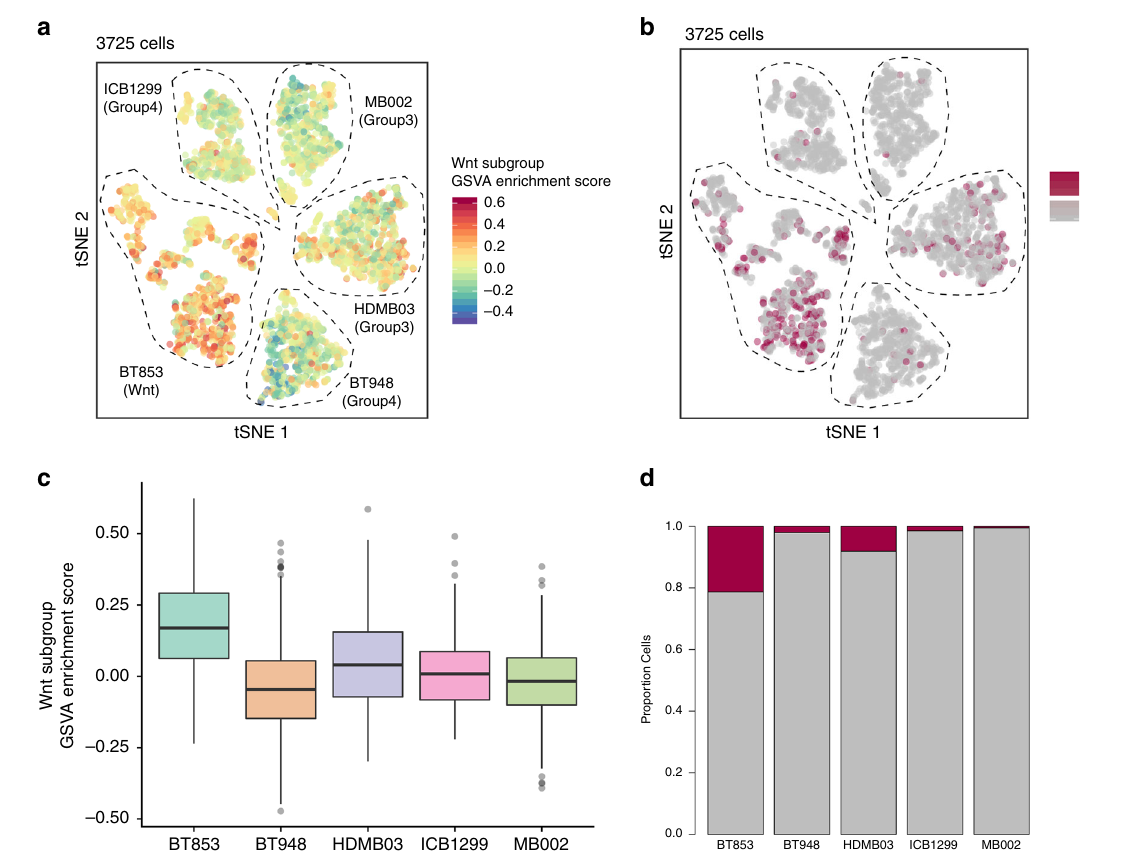
Fig. 2 Characterization of Wnt activity in Wnt, Group 3, and Group 4 MBs. Heterogeneous Wnt subgroup scored across patient-derived MB cultures. a tSNE of 3725 cells colored by GSVA enrichment score for the Wnt subgroup gene signature. b Cells colored by classi fi cation for enrichment of Wnt subgroup signature. Dark red cells surpassed the 5% cutoff and are considered signi fi cantly enriched for the gene signature. Gray cells did not pass the threshold. c Wnt subgroup signature scores for each sample. Each point in the box plot represents a cell ( n = 3725 cells from fi ve samples). Box plots represent the median, upper, and lower quartiles of the distribution and whiskers represent 1.5x IQR or the most extreme value. Outliers represented as circles. d Proportion of cells enriched for the Wnt subgroup gene signature per